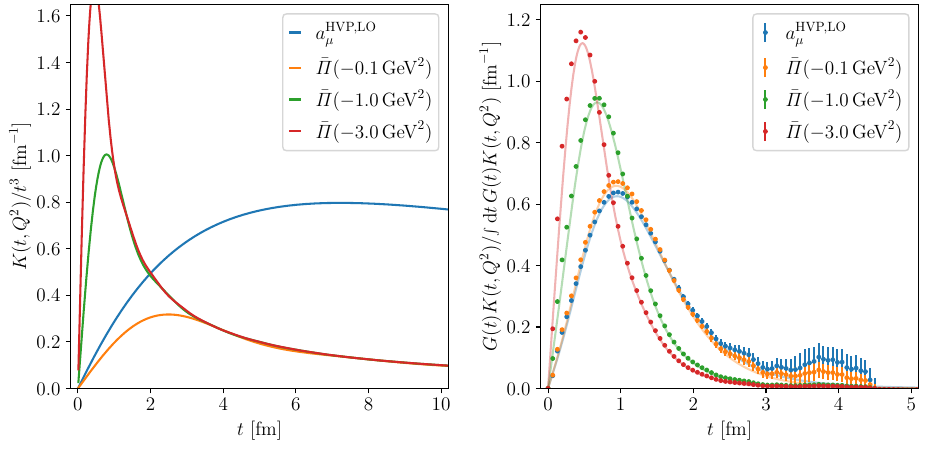
Figure 1 . Left: the kernel K ( t, Q 2 ) of the TMR integral in eq. (3.1) for different values of Q 2 , compared to the kernel w ( t ) for a HVP , LO [61, 63] (blue line), as a function of time t . All kernels are µ divided by t 3 in the plot, such that they tend to zero at t → ∞ while being still zero at t = 0 . Right: contribution of G ( t ) K ( t, Q 2 ) to the TMR integral normalized to the value of the integral, comparing different kernels. The light colored lines are drawn using a model for the Euclidean-time correlator G ( t ) [61], that is also used for the integral, while the data points with error bars are obtained using actual lattice correlator data at the physical pion